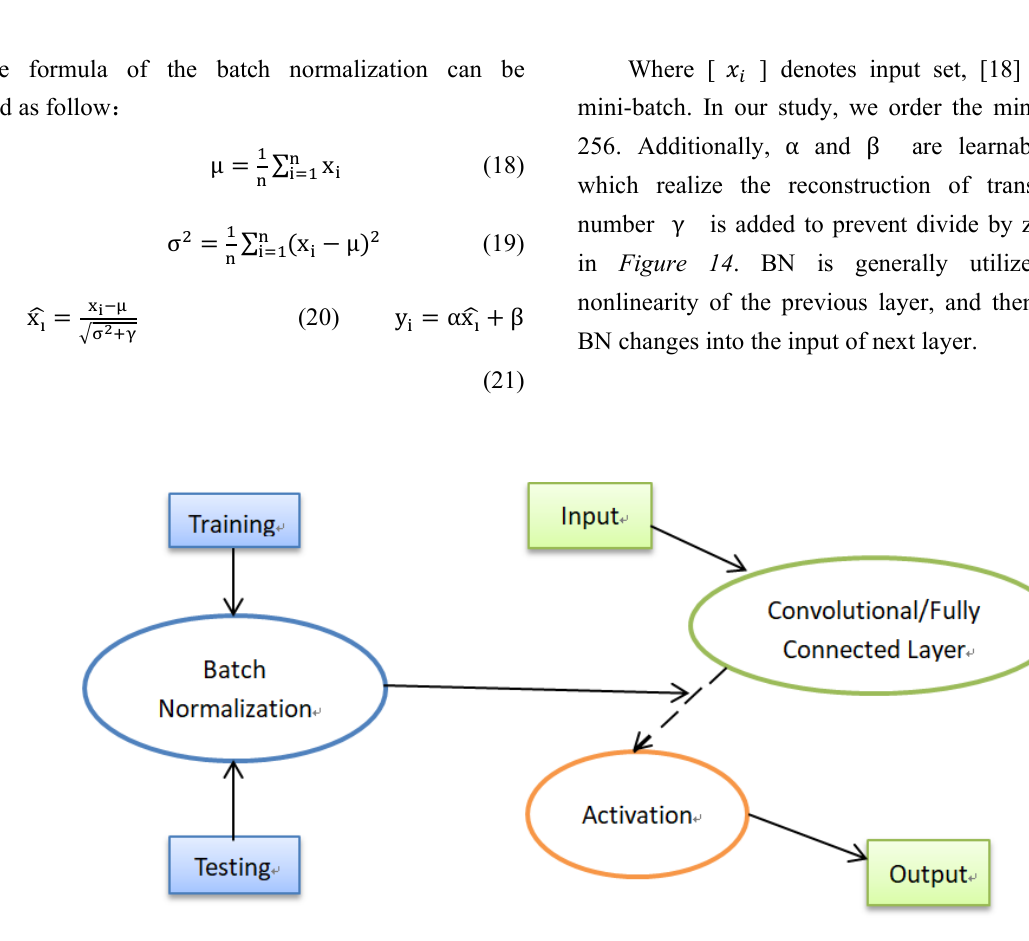
Figure 14. Structure illustration of batch